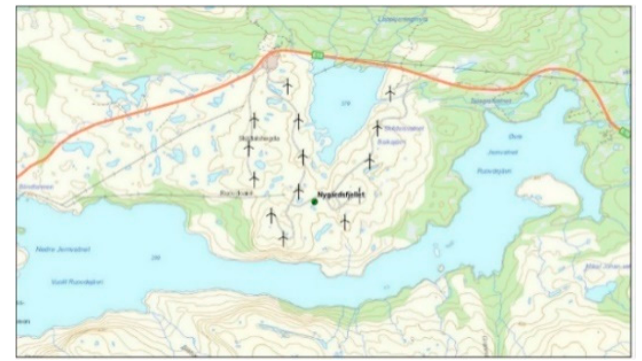
Figure 8. Wind farm location and layout.